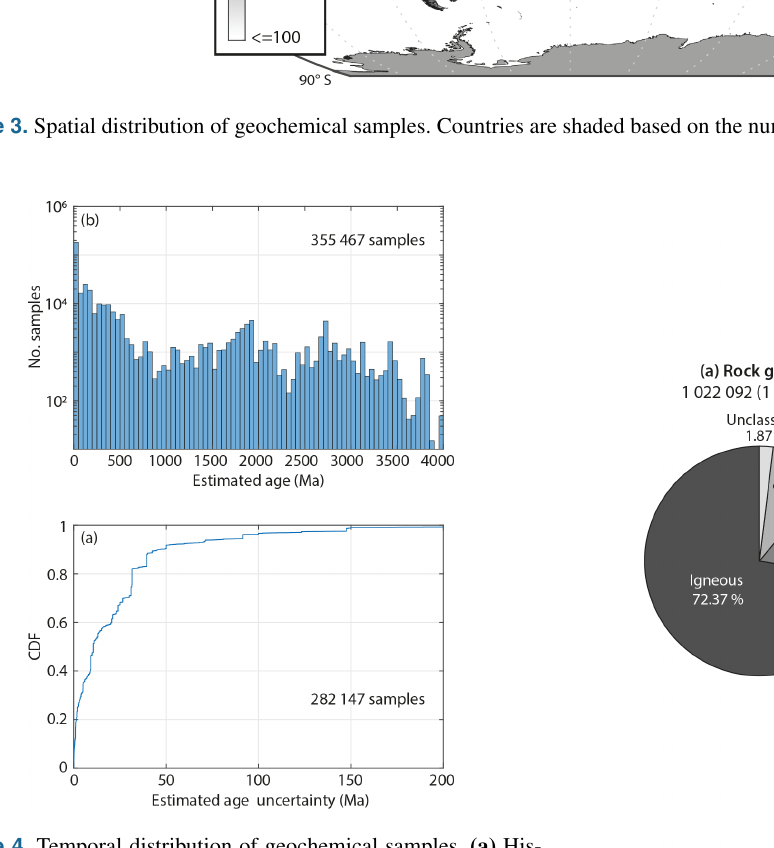
Figure 4. Temporal distribution of geochemical samples. (a) His- togram of mean ages in 50Ma intervals. (b) Empirical cumulative distribution function (CDF) of age uncertainty (major time period associated ages removed). Figure 5. Rock group partitioning. (a) Pie chart depicting distri-